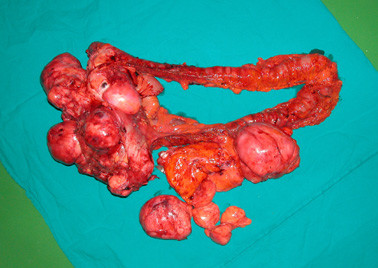
Multiple tumoral nodules in colon serosa and mesocolon are shown in gross specimen after performing total colectomy.